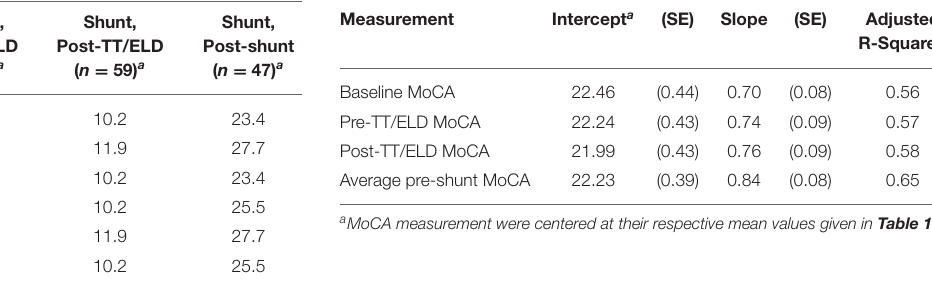
TABLE 2 | Percent patients labeled as having a reliable change in MoCA from baseline to tap test, shunt insertion.